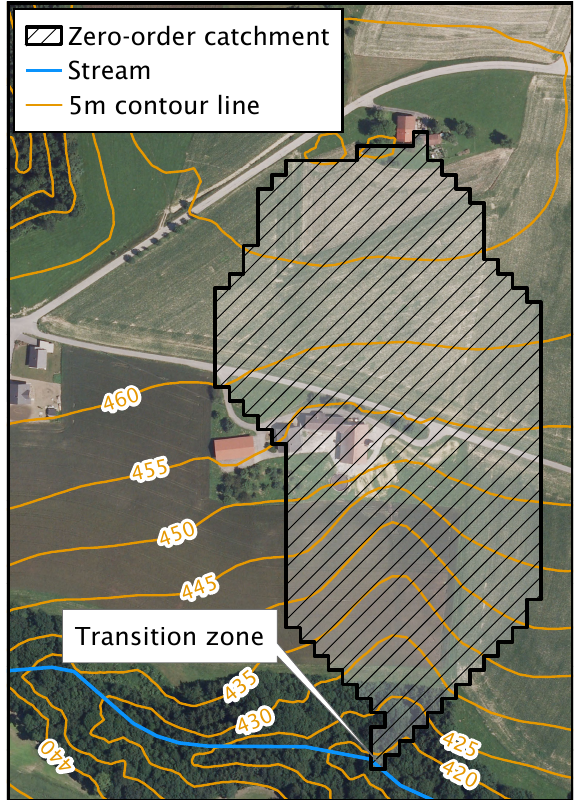
Figure 1. Example of a zero-order catchment (catchment area belonging to a single overland-channel transition zone) based on a DEM with 10 × 10m resolution and the D8 single flow direction algorithm